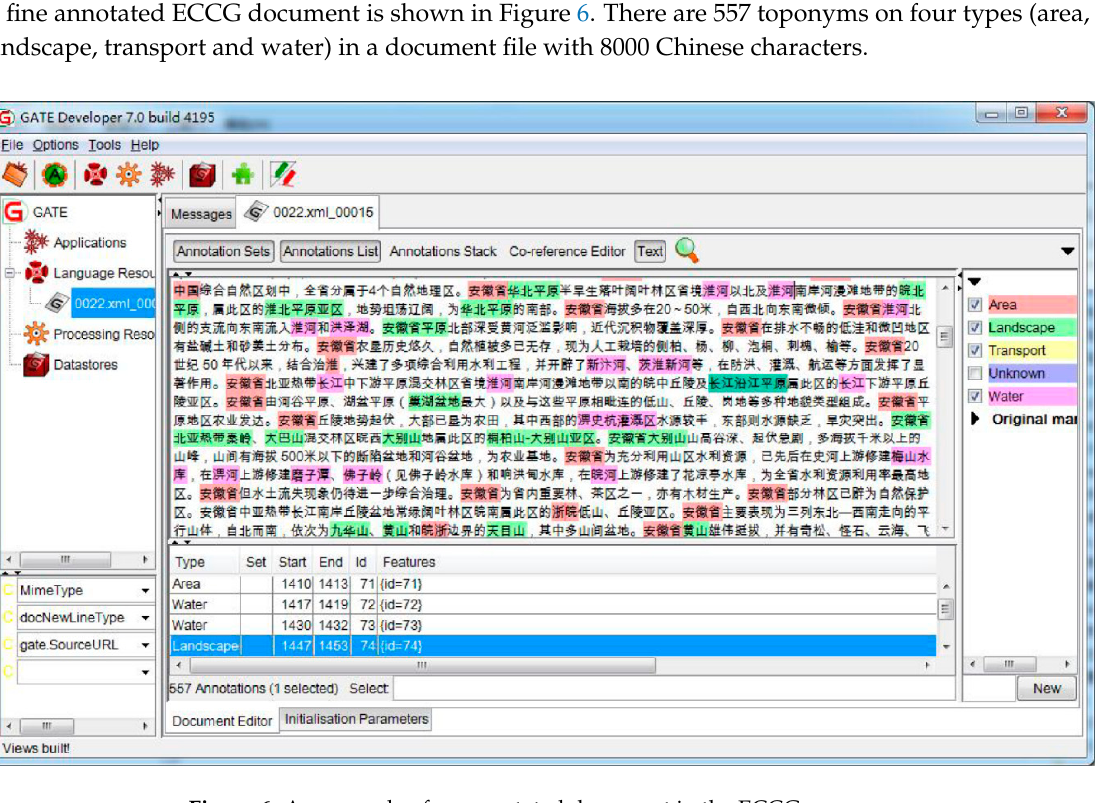
Figure 6. An example of an annotated document in the ECCG corpus.